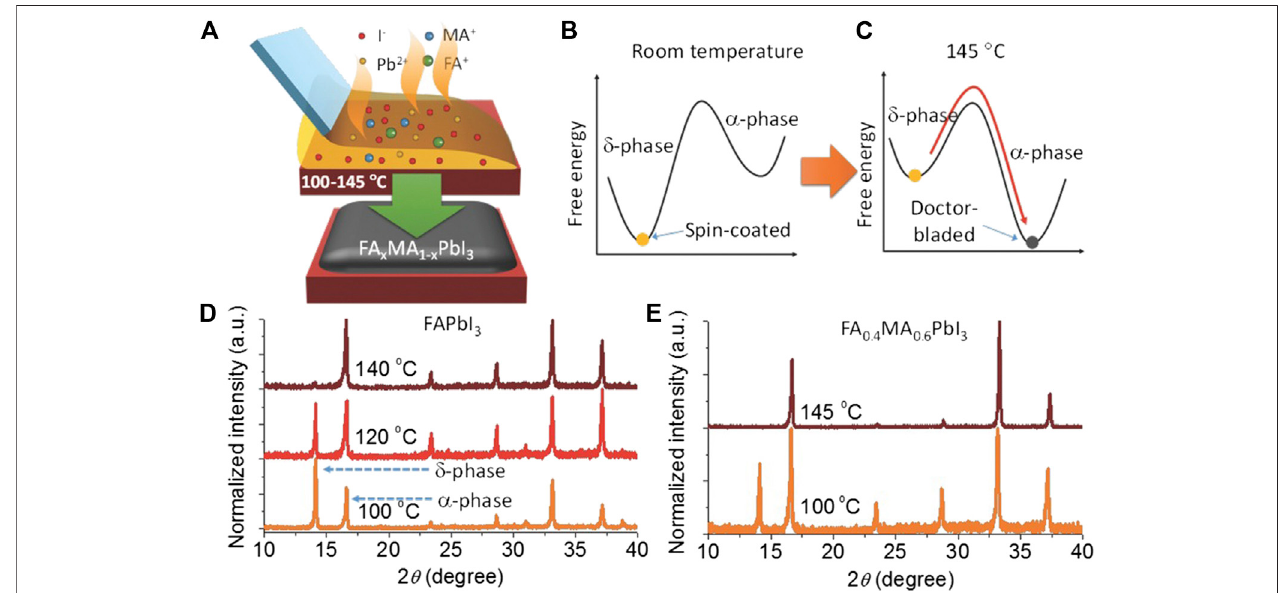
FIGURE 6 | Formation of the mixed cation perovskite fi lm in ambient conditions using the hot-substrate method (A) Illustration of the blade-coating method on the hotsubstrateattemperaturebetween100 ° Cand145 ° C.Illustrationofthefreeenergyof α -phaseand α -phaseat (B) roomtemperatureand (C) at145 ° C.Phasepurityis illustratedand characterizedbyX-raydiffractionfor (D) FAPbI 3 and (E) FA 0.4 MA 0.6 PbI 3 ,respectively,atdifferentsubstratetemperatures. Reprinted withpermission from Deng et al. (2016). Copyright 2016 WILEY-VCH Verlag GmbH & Co. KGaA, Weinheim.